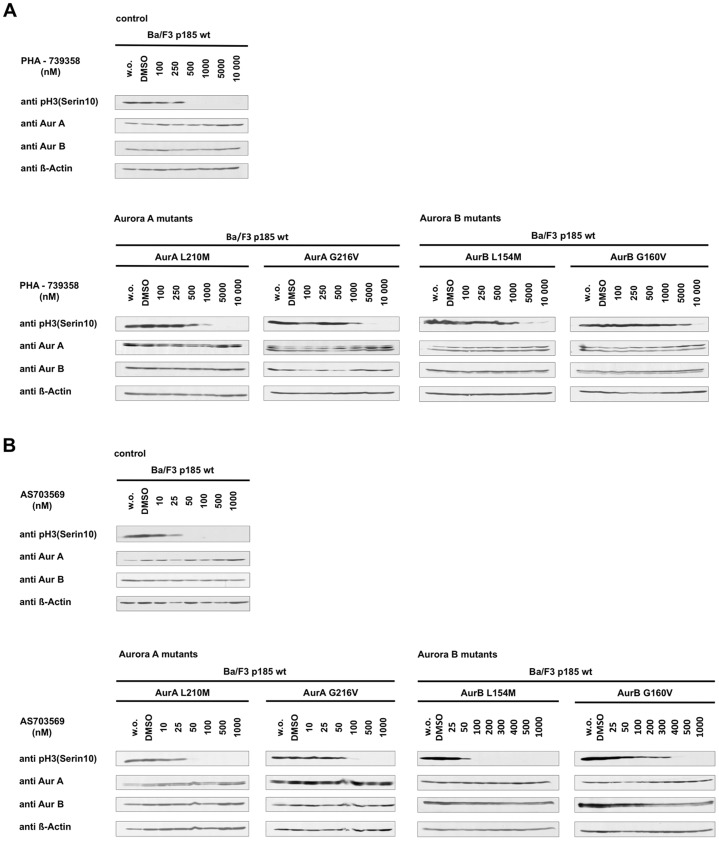
Aurora B G160V mutant confers resistance to PHA-739358 and R763/AS703569.Western blot analysis probed to investigate the resistant potential of Aurora A and B kinase mutants by detecting phospho-Histone-3 (serine 10) after 2.5 h exposure to increasing concentrations of PHA-739358 (A) or AS703569 (B). Untreated and DMSO treated cells were used as control. For comparison untransfected Ba/F3 p185 wt cells were also included into the experiment.